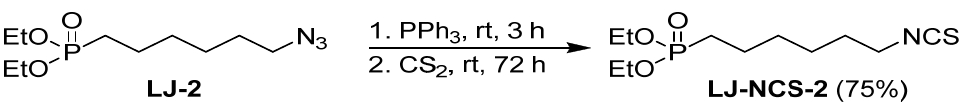
Figure 3. Microwave-assisted synthesis of LJ-NCS-3 using DMT/NMM/TsO − . Figure 4. Synthesis of LJ-NCS-2 in Staudinger/aza–Wittig reaction. Figure 4. Synthesis of LJ-NCS-2 in Staudinger/aza–Wittig Figure 4. Synthesis of LJ-NCS-2 in Staudinger/aza–Wittig reaction.